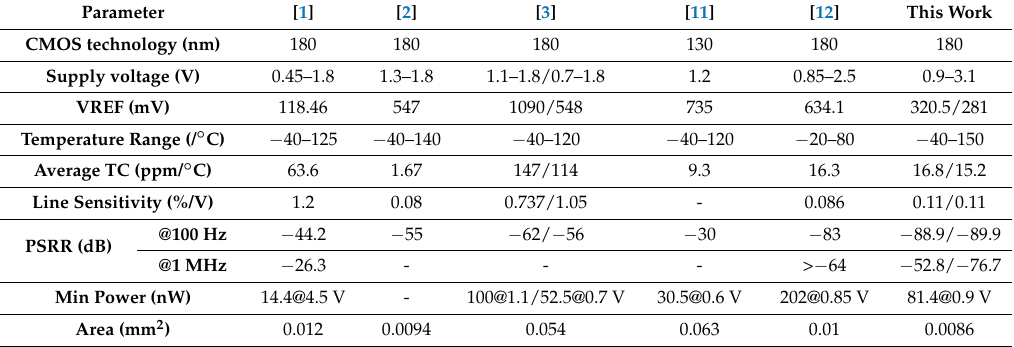
Table 3. The performance comparison of proposed voltage